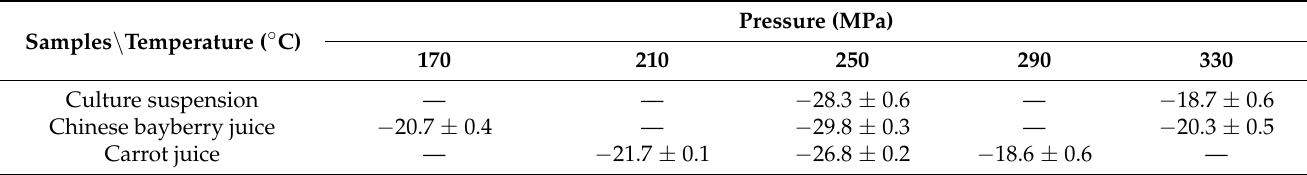
Table 1. Temperature–pressure conditions employed for the destruction of E. coli in culture suspen- sion, Chinese bayberry juice, and carrot juice.